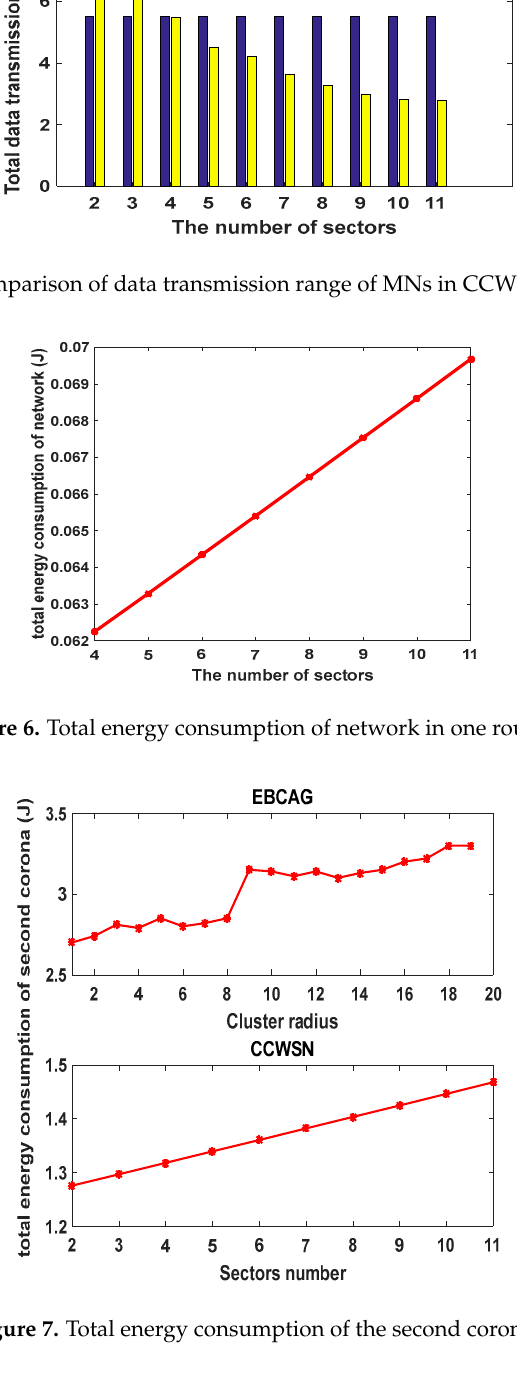
Figure 8. Total energy consumption in our proposed method, DBS and corona-based WSN without applying clustering.